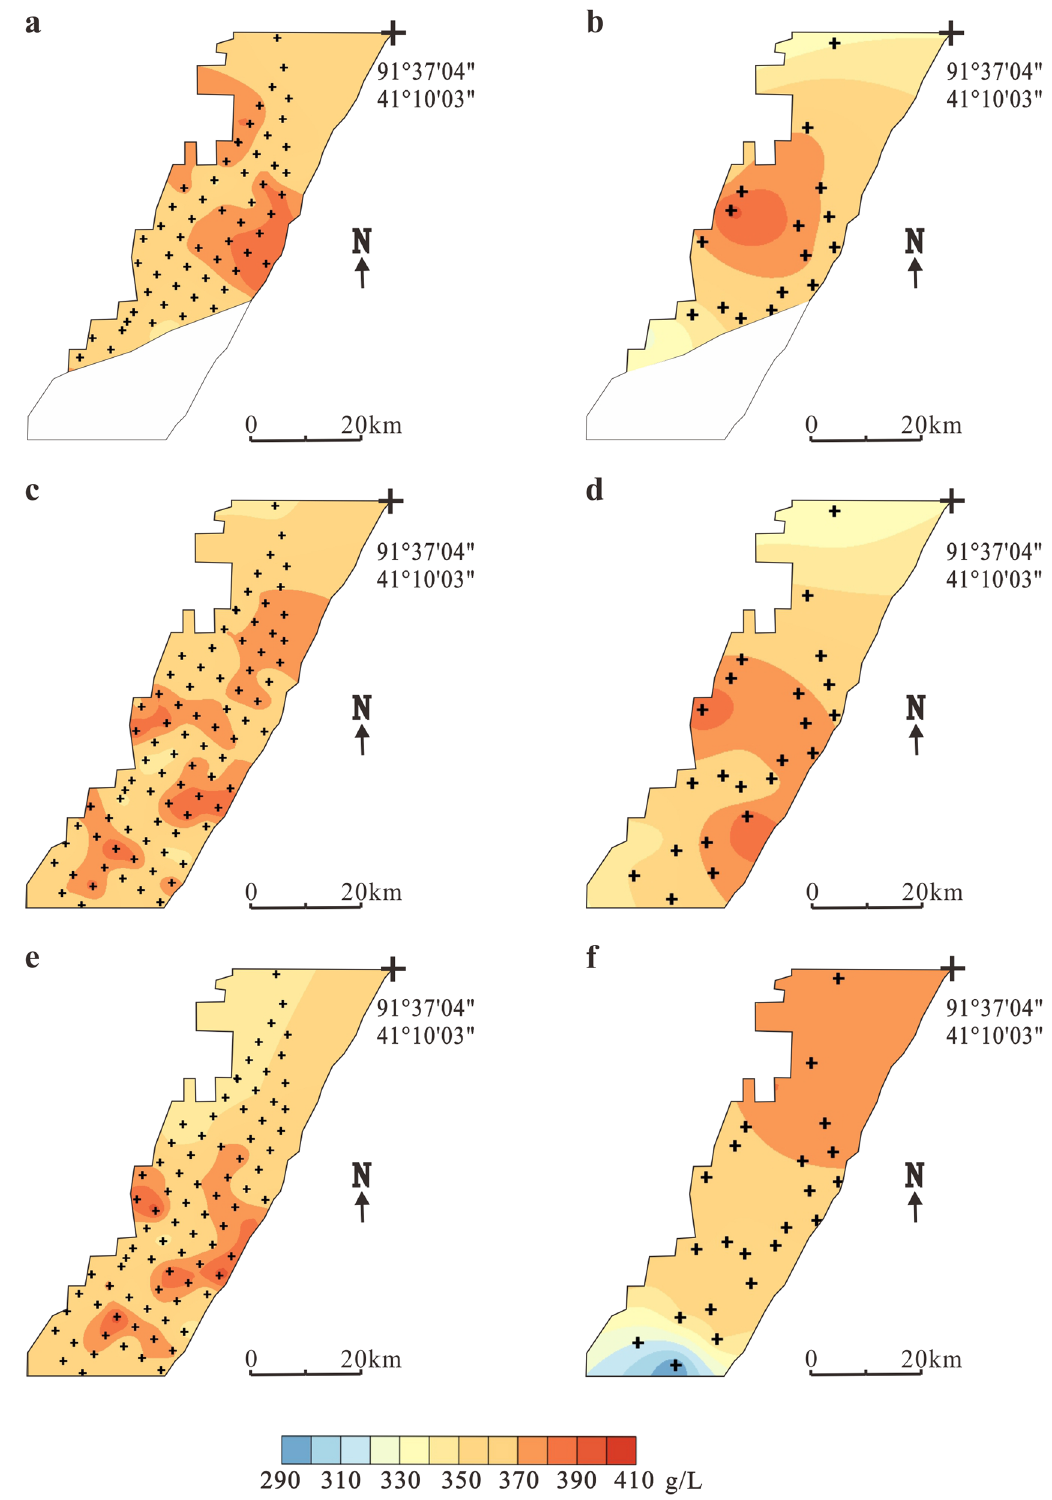
Figure 5. Temporal and spatial variations in salinity of different brine layers in Tenglong platform. ( a ) Layer W 1 in 2009, ( b ) Layer W 1 in 2017, ( c ) Layer W 2 in 2009, ( d ) Layer W 2 in 2017, ( e ) Layer W 3 in 2009 and ( f ) Layer W 3 in 2017. The black crosses indicate observation holes